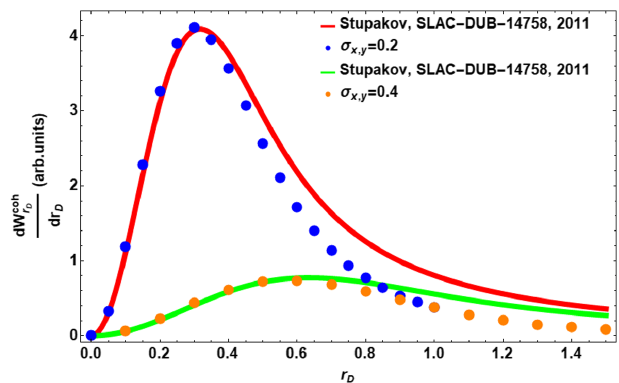
FIG. 16. COTR based image calculated for an azimuthal symmetric bunch. In addition, the results of Ref. [21] are